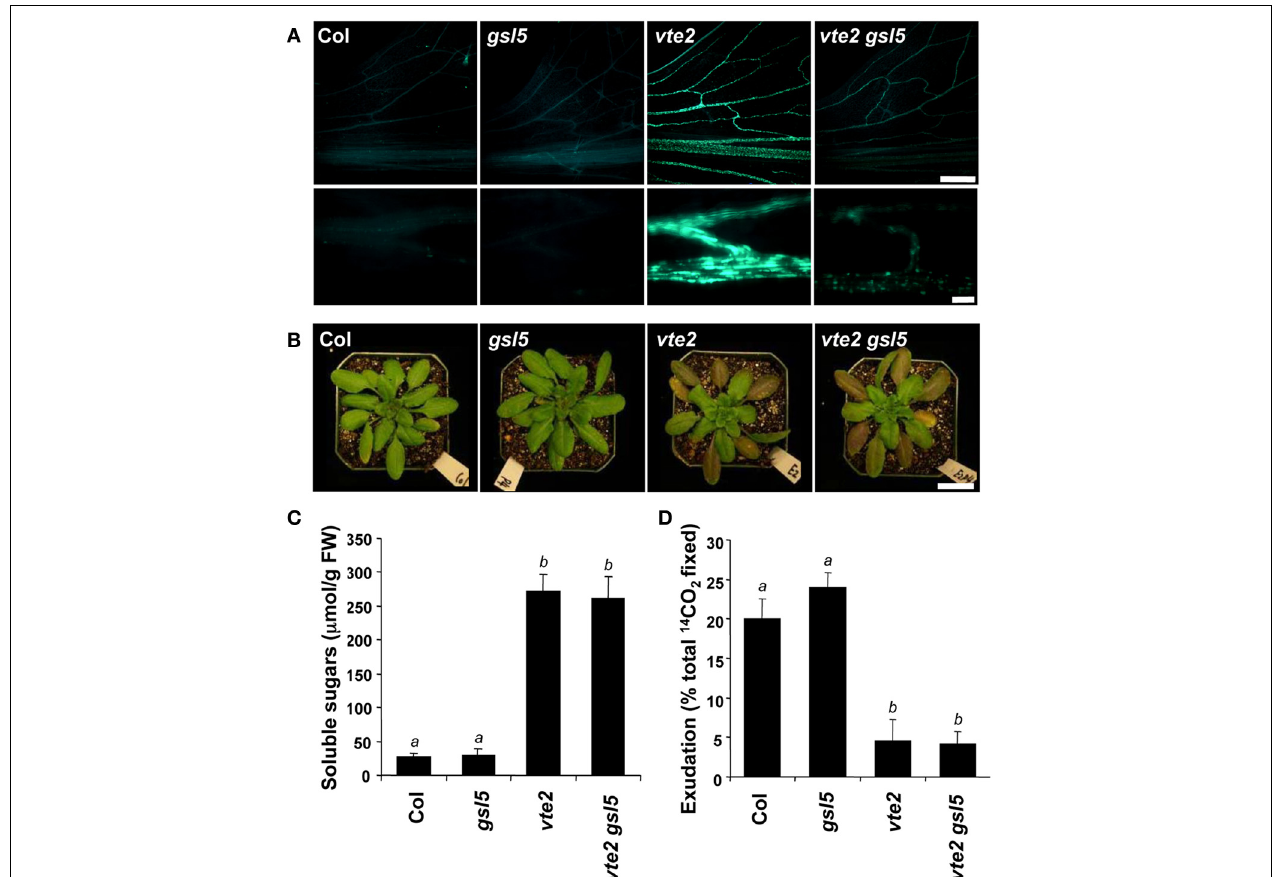
FIGURE 5 | Characterization of the g sl5 vte2 mutant at LT. Col, gsl5 , vte2 , and gsl5 vte2 were grown under permissive conditions for 4 weeks and transferred to LT conditions for the indicated times previously shown to maximize each phenotype (Maeda et al., 2006). (A) Aniline-blue positive fluorescence in the lower portions of leaves after 7 days of LT treatment. Samples for callose staining were fixed in the middle of the light cycle. Representative images are shown ( n = 3). The bottom panels are higher